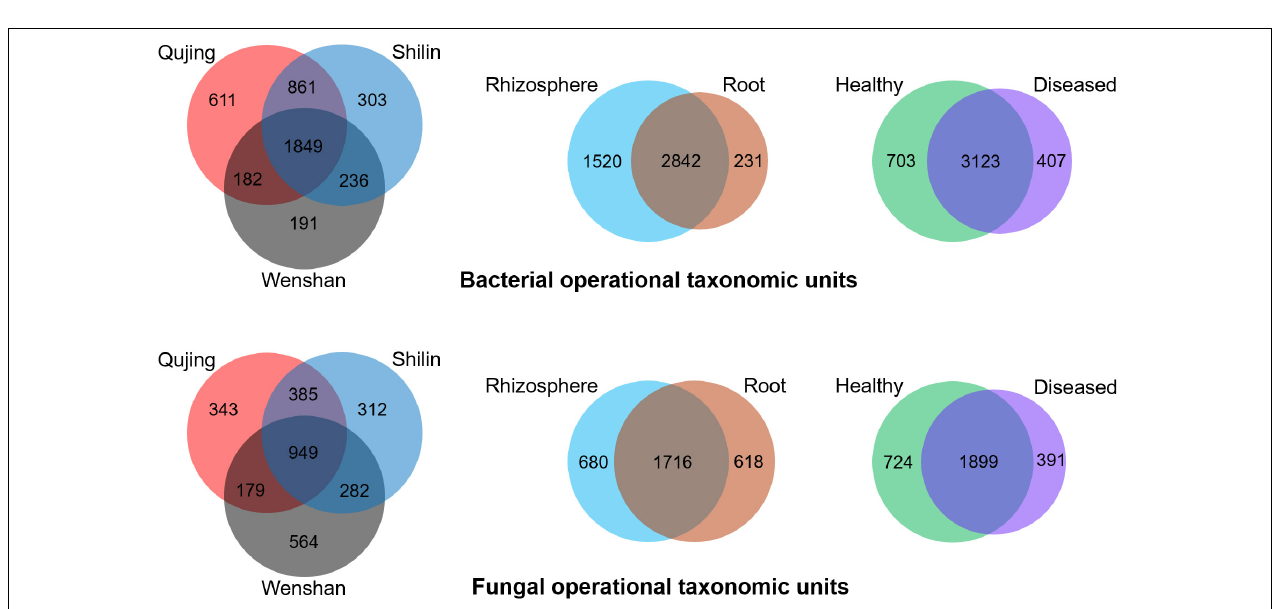
FIGURE 4 | Distribution of bacterial (top) and fungal (bottom) operational taxonomic units in three variables, i.e., locations (Qujing, Shilin, and Wenshan), plant components (rhizosphere soil and roots), and sample types (healthy and diseased).